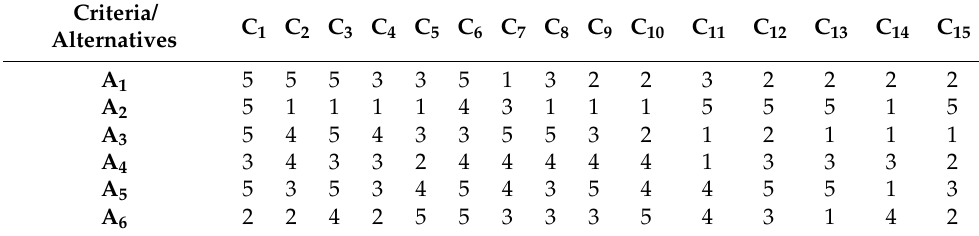
Table 14. Scoring of alternatives for each criterion of Incubator X.